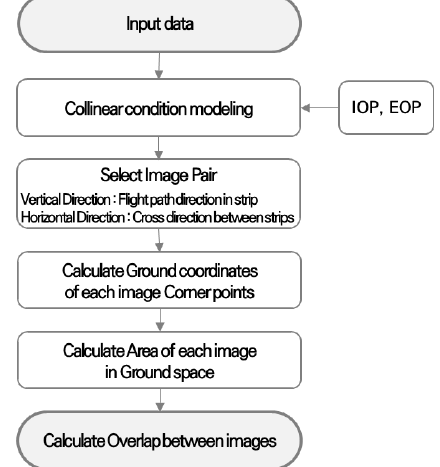
Figure 6. Overlap between images analysis process